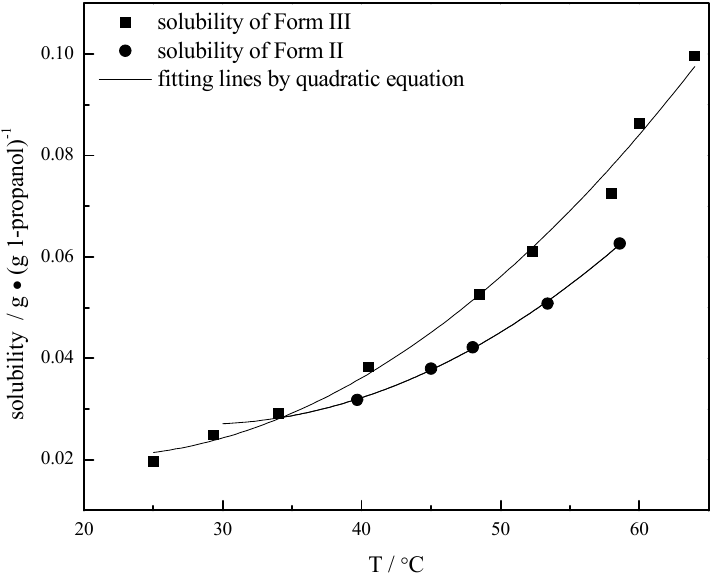
Figure 5. The solubility-temperature diagram and fitting curves for carbamazepine of Forms II and III.